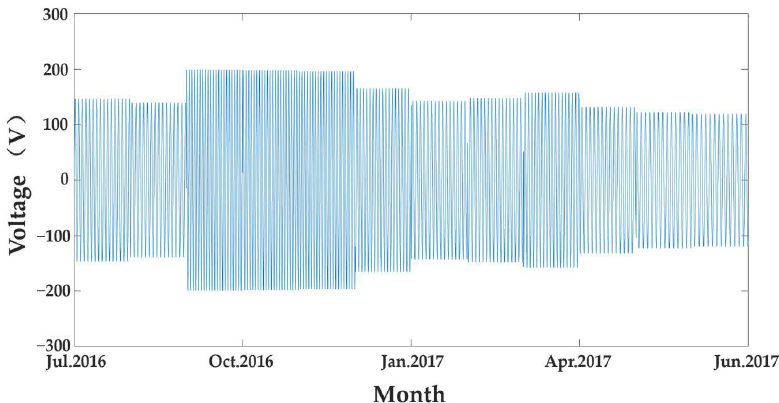
Figure 11. Annual variation pattern of electricity generated by tidal power.